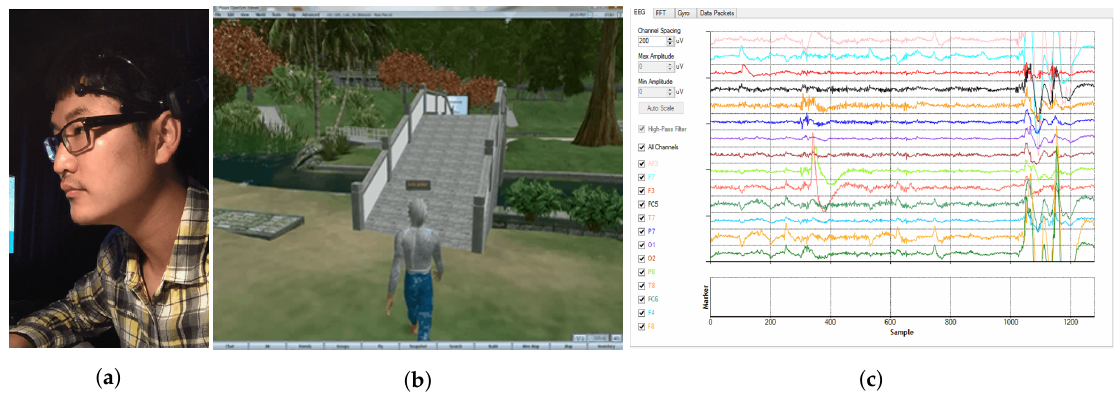
Figure 13. Implementation of EEG -based Virtual Geographic Cognitive Experiment. ( a ) Participant in the real world; ( b ) Avatar in the virtual environment; ( c ) Participant’s real-time EEG wave.